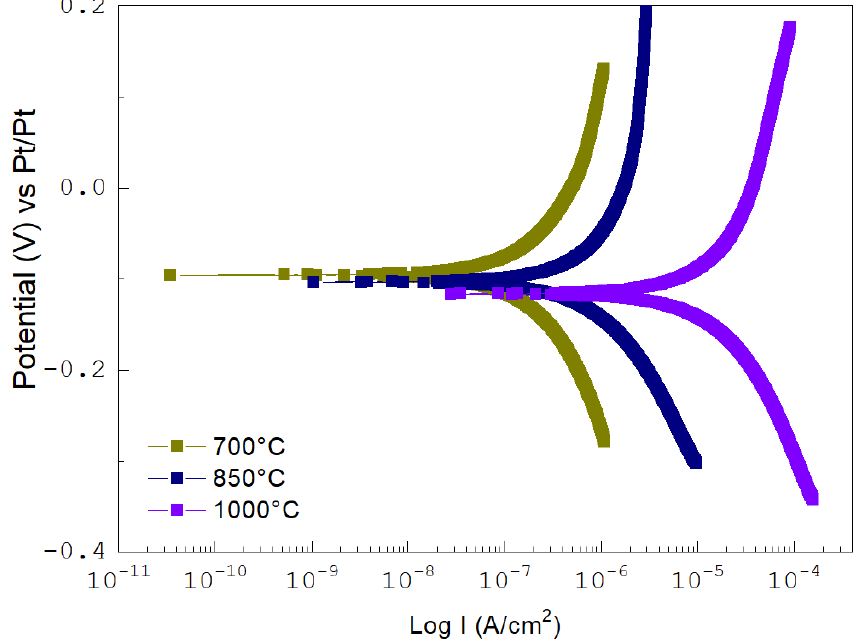
Figure 3. Potentiodynamic curves for Bi 3 . 75 La 0 . 25 Ti 3 O 12 coatings evaluated at temperatures of 700 °C, 850 °C and 1000 °C. Table 2. The corrosion potential, current density, and corrosion rate obtained for Bi 3 . 75 La 0 . 25 Ti 3 O 12 at 700 °C, 850 °C, and 1000 °C.